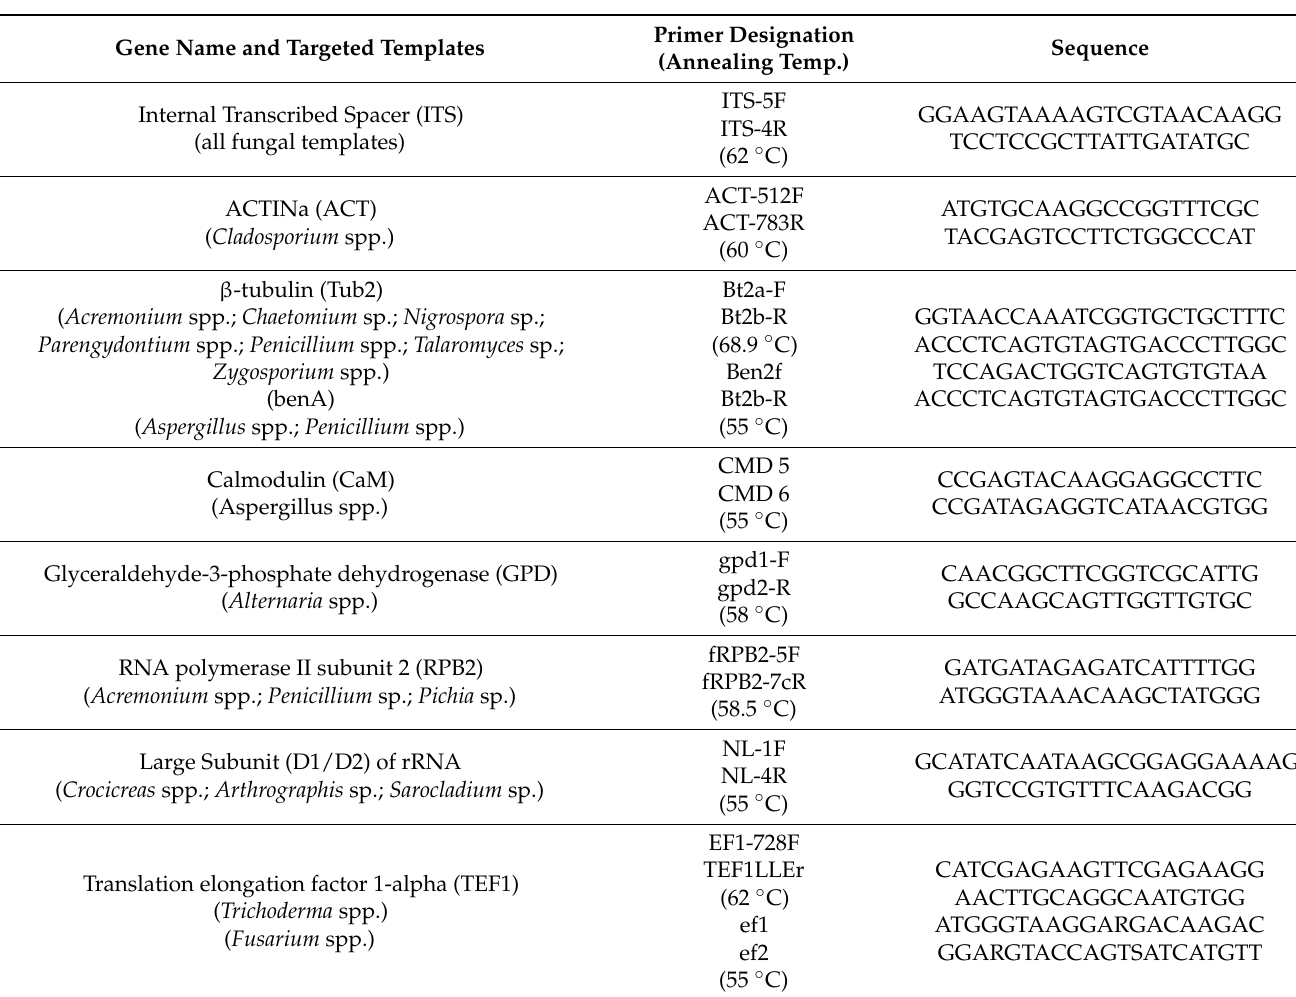
Table 1. Primers used in this